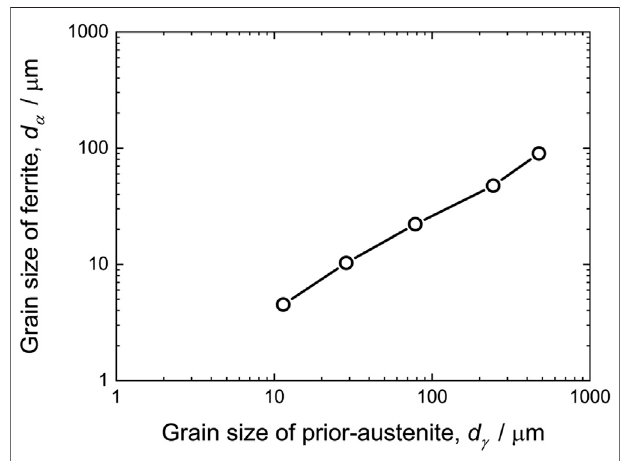
size monotonously decreased with decreasing the prior-austenite grain size. It is noteworthy that the ferrite grain size became always fi ner than the prior-austenite grain size.